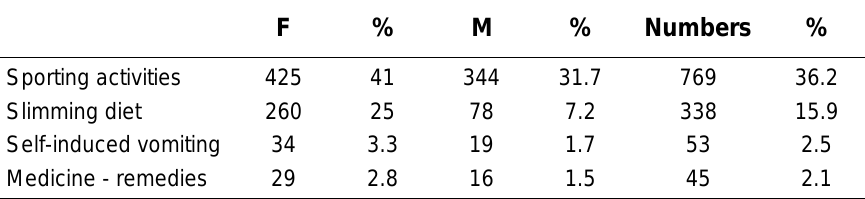
Slimming Strategies Adopted by Teens Dissatisfied with their